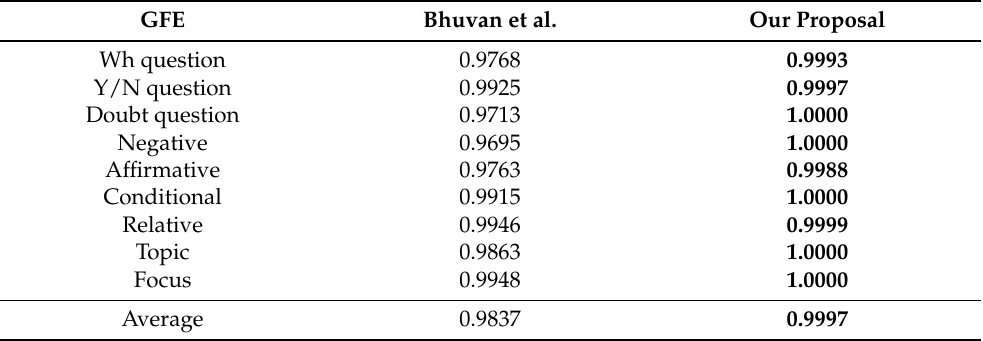
Table 3. ROC-AUC scores achieved by our proposed model and other state-of-art approaches using a dataset that stores grammatical facial expressions of the Brazilian sign language (Libras) made by subject one. Best results are in